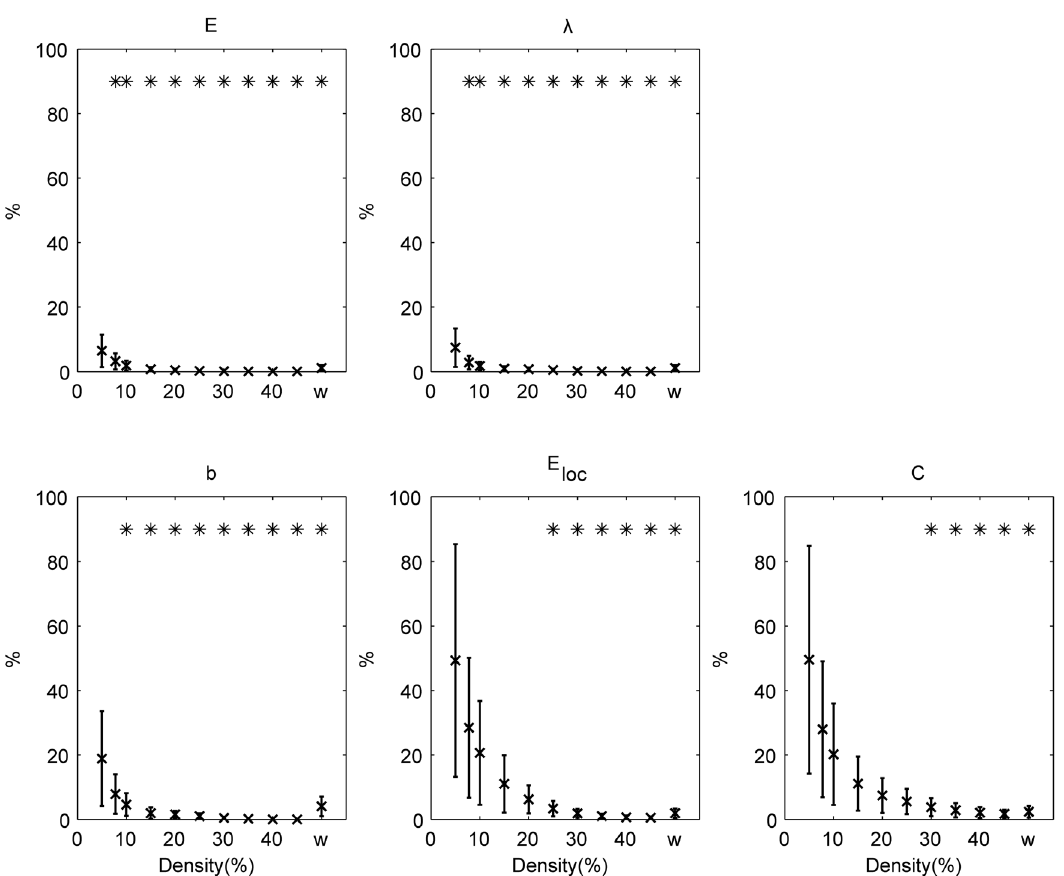
Fig. 2. Intra-subject split-half test-retest variability (%). The results are shown for binary (over a range of densities) and weighted (w) networks. Error bars refer to the standard deviation across all randomization and subjects. E : global efficiency; l : the characteristic path length; b : the mean betweenness centrality; E loc : the mean local efficiency; C : the mean clustering coefficient. Test-retest variabilities significantly ( p cor v 0 : 05 ) lower than 10% are indicated with *.